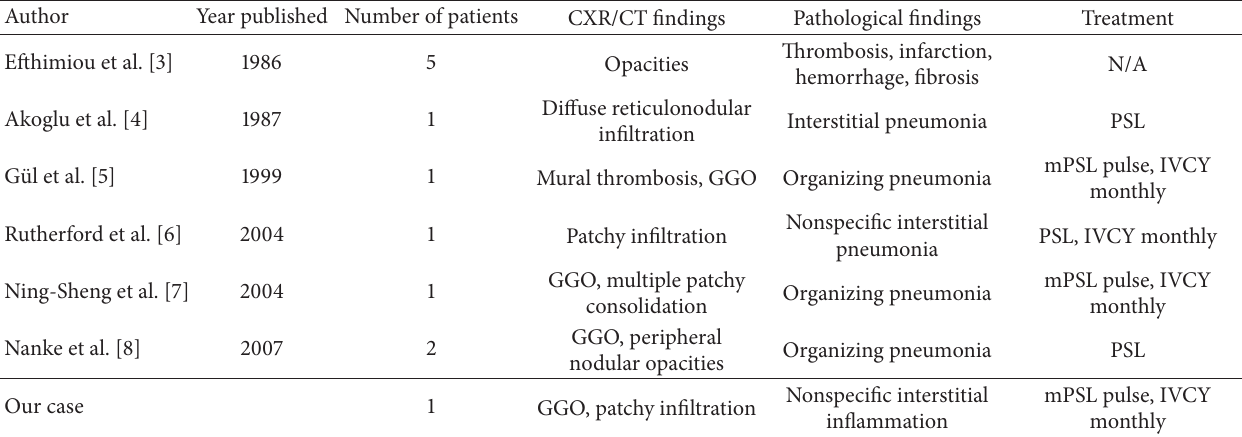
Table 1: Previous reports of interstitial pneumonia in patients with Behc¸et’s disease and our